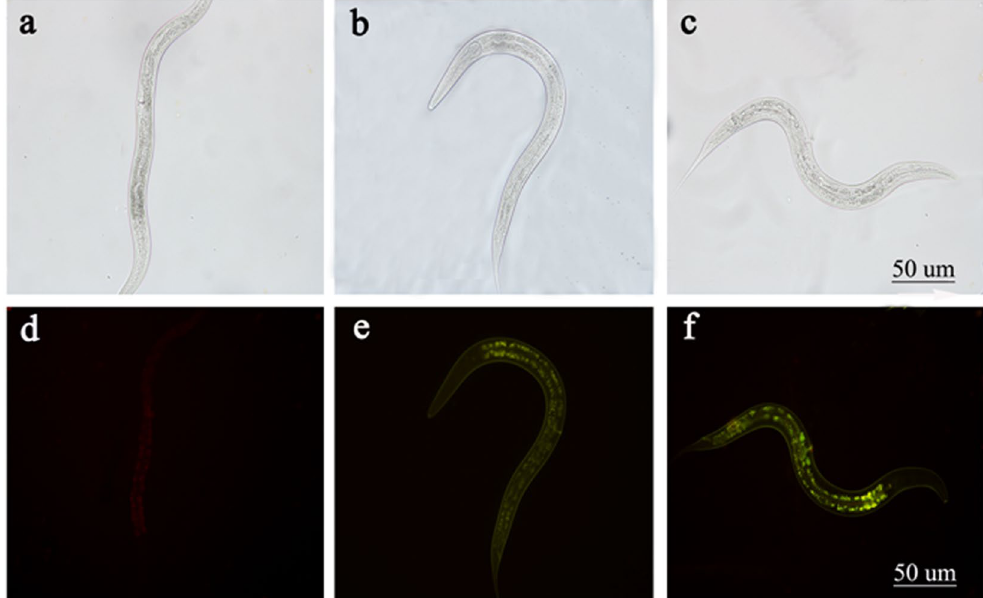
Figure 5. Bright-field image (top) and fluorescent image (bottom) in C. elegans . ( a ) Probe (1)(20 µ M) only. ( b ) Probe (1) (20 µ M), NADH (100 µ M), and nitroreductase (NTR) (10 µ g/ml). ( c ) Probe1(20 µ M), NADH (100 µ M), and NTR (20 µ